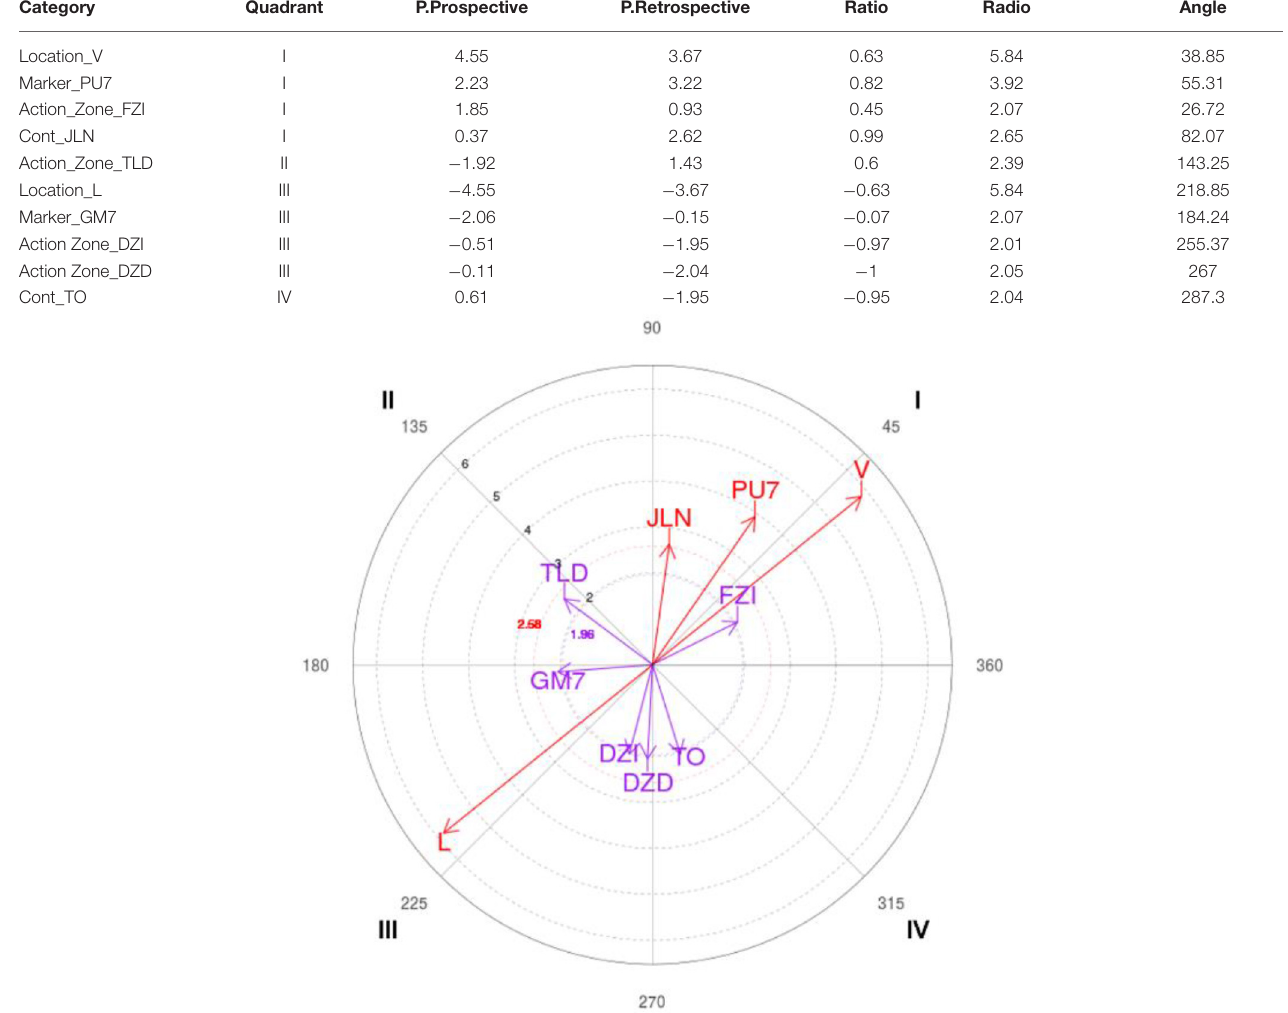
TABLE 5 | Significant relationships and vector representation between outdoor 1x1 focal behavior (UxE) and mating behaviors for all observations. Category